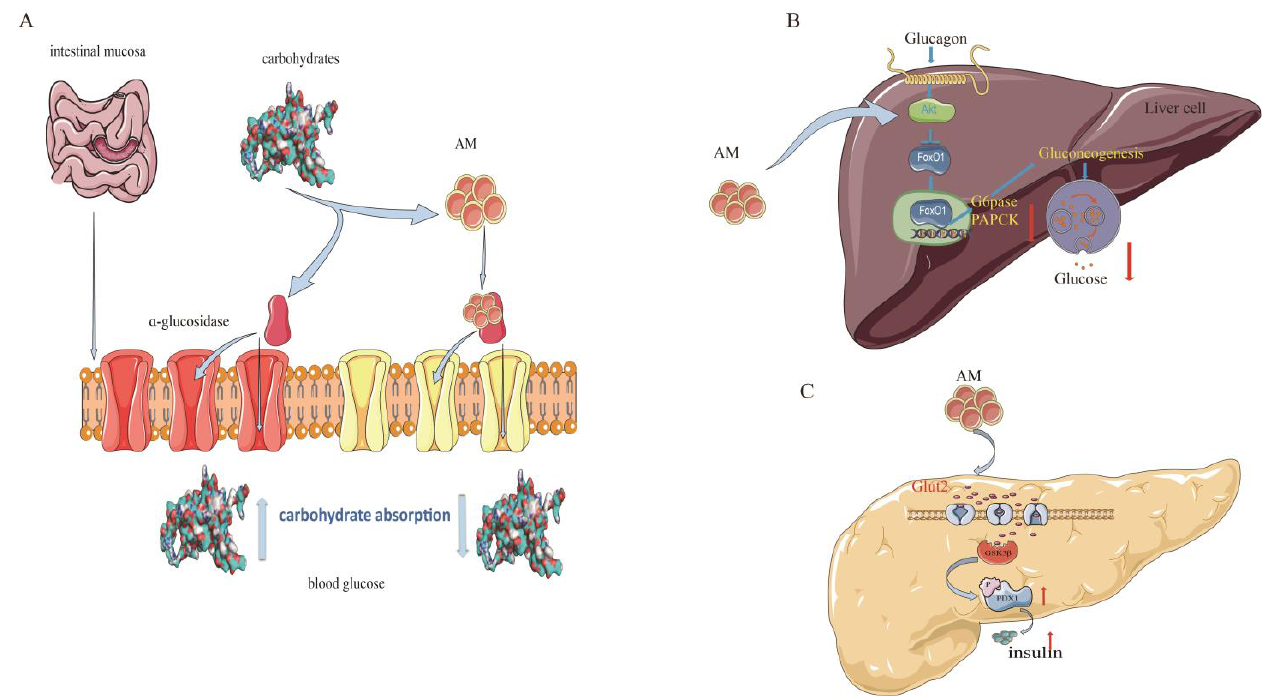
Figure 5. Mechanism of AM for its anti-diabetic effects. ( A ) Inhibition of α -glucosidase; ( B ) con- straint of gluconeogenesis; and ( C ) promotion of pancreatic duodenal homeobox-1 expression. Alpha-glucosidase is a critical enzyme associated with T2DM. The inhibition of α -glucosidase is considered an effective approach or treatment for T2DM owing to its potential for reducing glucose absorption by preventing carbohydrate digestion [43]. AM shows a strong α -glucosidase inhibitory activity, with a half-maximal inhibitory concen- tration (IC 50 ) value of 37.4 µM and noncompetitive inhibition, with a Michaelis constant (k I ) of 17.3 µM, which is higher than that of the representat ive α -glucosidase inhibitor